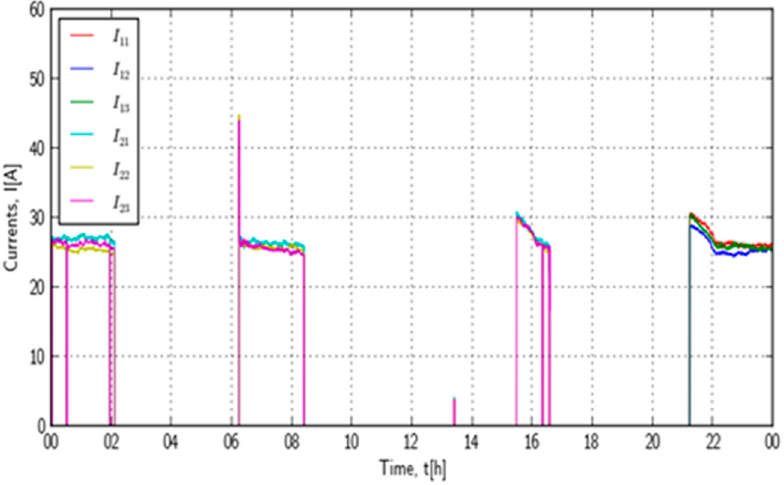
Figure 24. The simulation of the PU2 and PU1 load current changes on 25 June 2009. (n = 2, t 1 = 15 min).